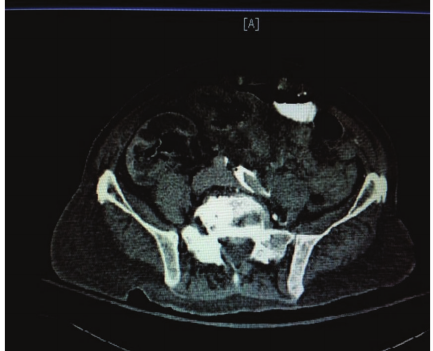
Figure5:CTscanoftheabdomenandpelvisshowinganedematous transplanted kidney with air in the intraparenchymal and pelvic regions and the